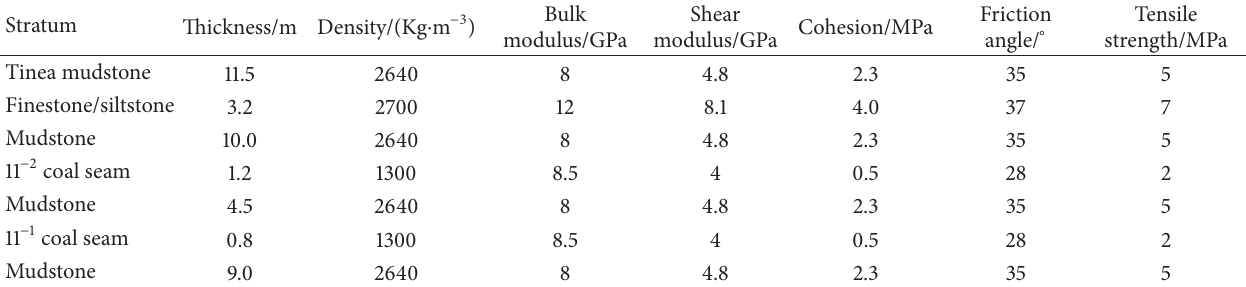
Table 1: Mechanical parameters of rock